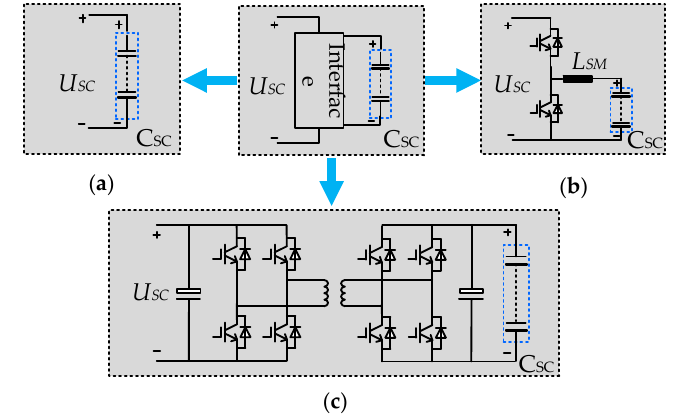
Figure 2. Topology of SCES-SM interface circuit: ( a ) Direct connection ( b ) Bidirectional buck/boost converter ( c ) Dual active bridge converter.